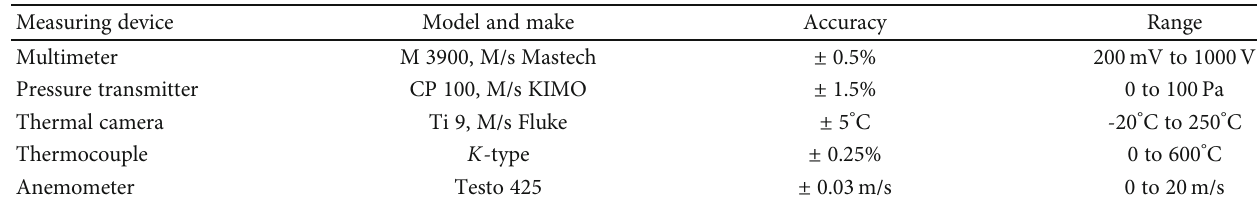
Figure 3: 3D model of test section with V- and W-shaped ribs. Table 2: Instrument